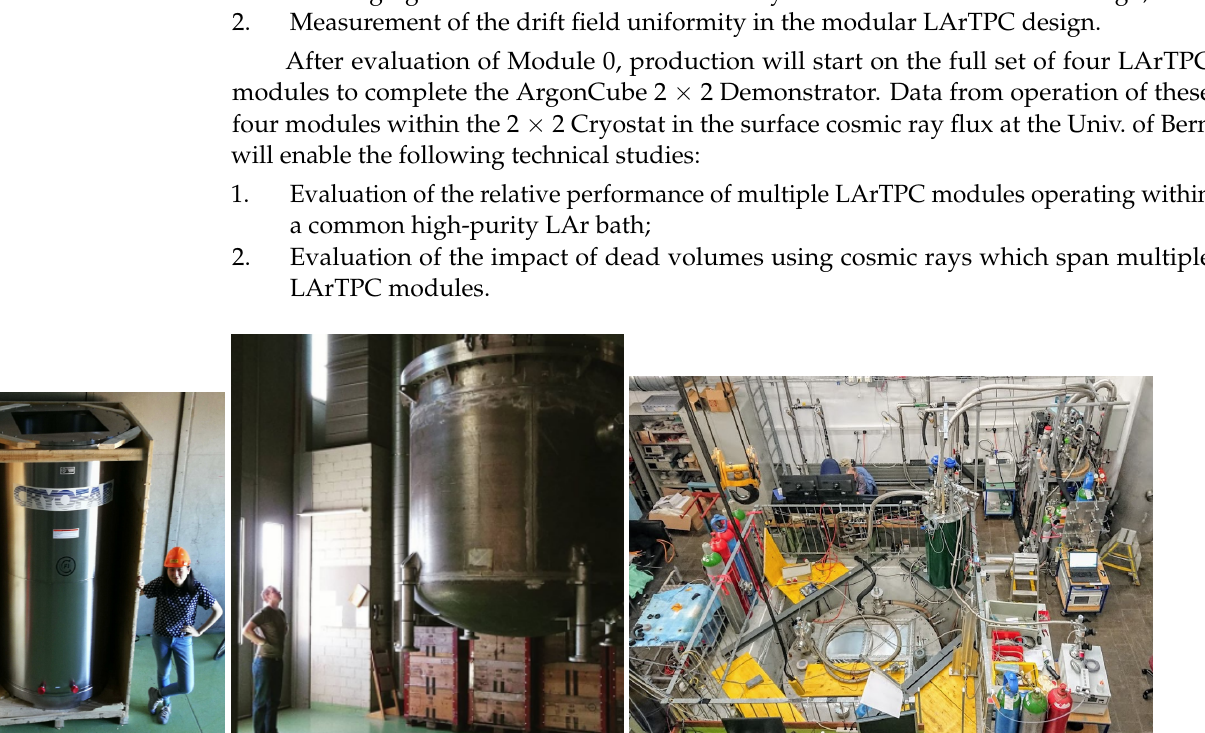
2 Demonstrator. ( Right ) ×